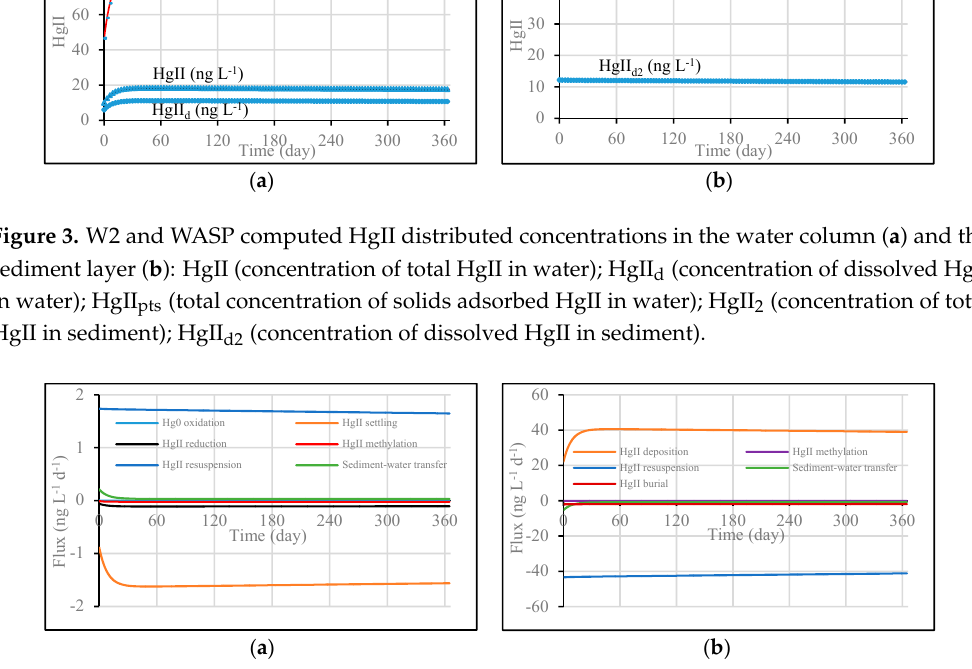
Figure 4. W2 computed HgII internal fluxes in the water column ( a ) and the sediment layer ( b ). Figure 5a,b show the comparison of W2 and WASP computed concentrations of MeHg in the water column and sediment layer. Figure 6a,b show W2 computed MeHg internal flux by each process. MeHg main source was from the methylation of HgII in the water column. Settling and